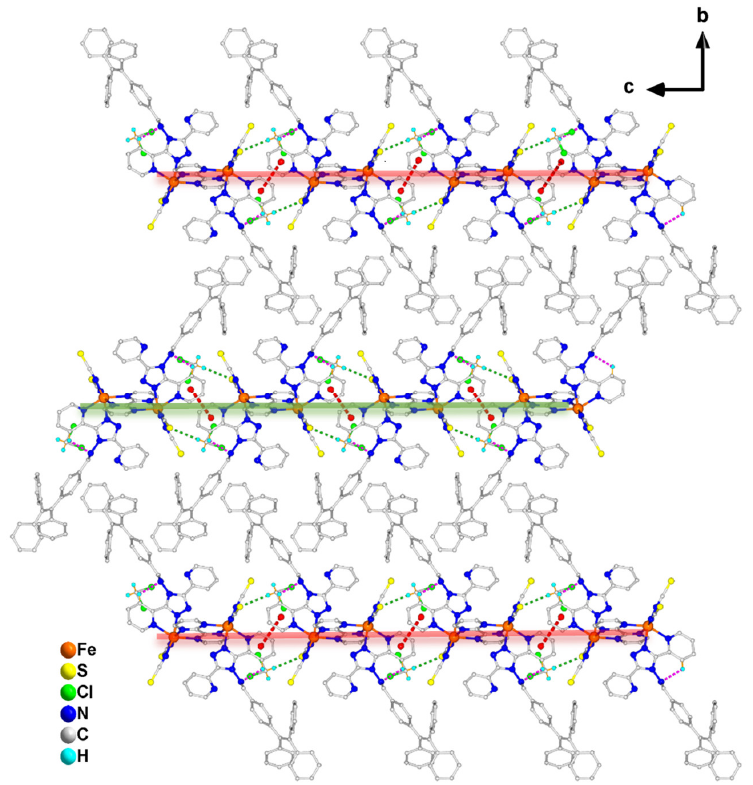
Figure 5. Schematic showing the crystal packing, lattice solvent distribution, hydrogen bonding, and π ··· π interactions of 2 at 100 K. The red dashed lines represent π ··· π interactions, and the green and pale purple dashed lines represent intramolecular hydrogen bonds.